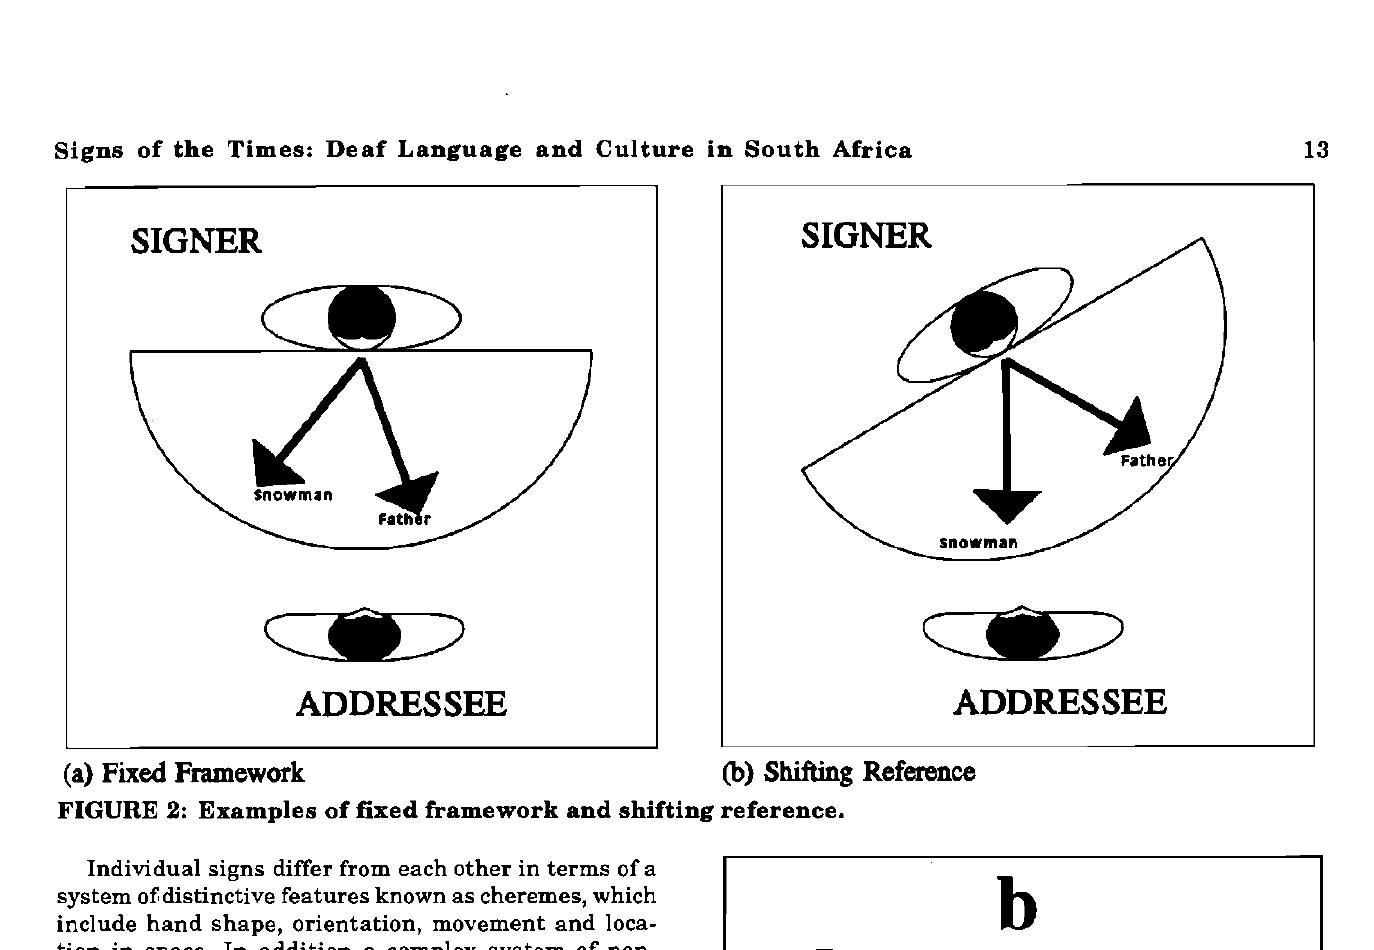
FIGURE 2: Examples of fixed framework and shifting reference.